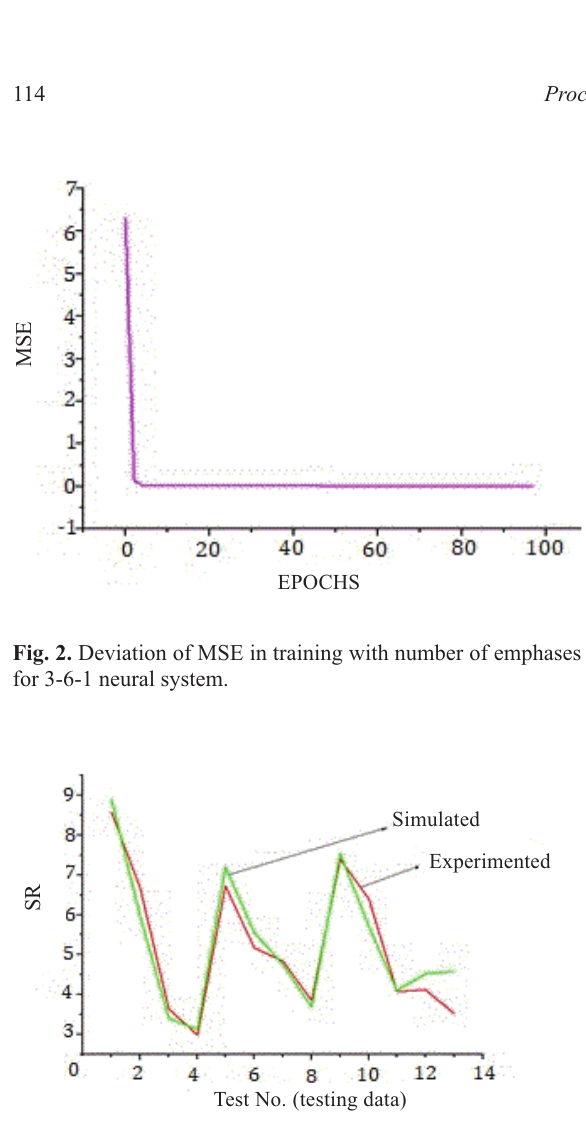
Fig. 3. A simulated and experimental surface roughness in testing data. Table 4. The percentage error in testing data